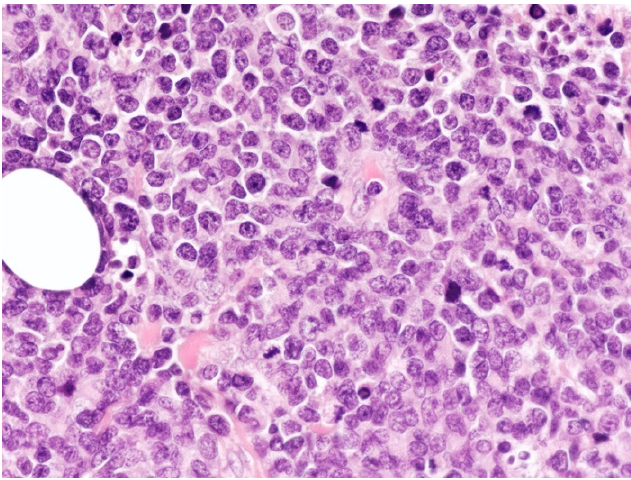
Figure 7. Cutaneous localization of MM: high-power view of the dense infiltrate, composed of large, atypical, polymorphic cells with a high nucleocytoplasmic ratio (HE, magnification 200×; original image from Prof. S.A.).